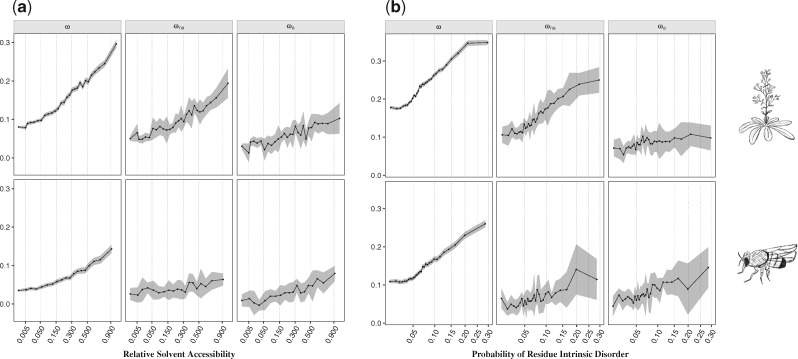
Relationship between ω, ωna, and ωa with (a) the relative solvent accessibility (RSA) and (b) the probability of residue intrinsic disorder for Arabidopsis thaliana (top) and Drosophila melanogaster (bottom). The x axis is scaled using a squared root function. Mean values of each estimate for each category are represented with connected black dots. The shaded area represents the 95% confidence interval of each category, computed over 100 bootstrap replicates.